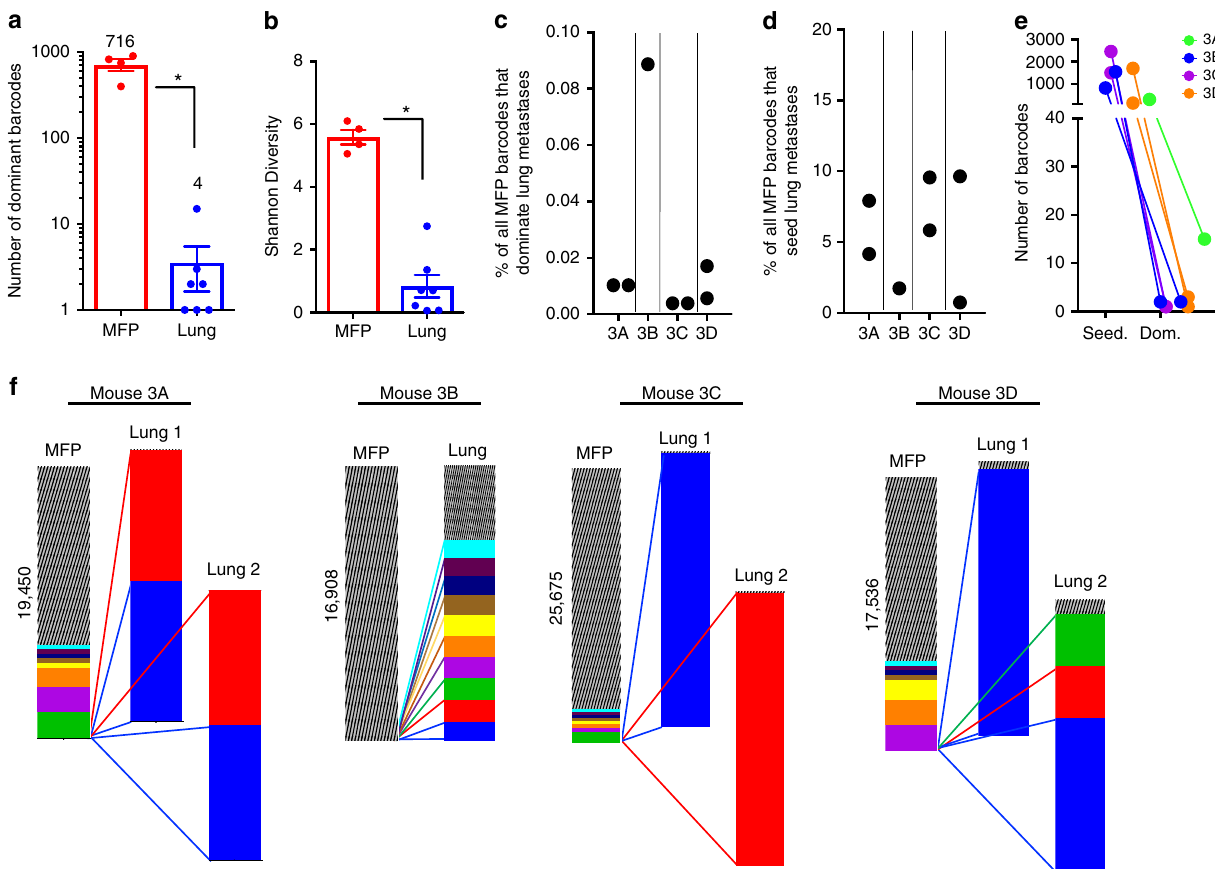
Fig. 6 An additional PDX model reveals clonal selection during metastasis. a In BC3_A2, unique dominant barcodes in each sample were quanti fi ed and plotted. The mean quantity of unique barcodes present in each site is depicted above each bar. (two-tailed T -test, * p = 9.40e − 6; error bars are SEM; n = 4 MFP tumors, n = 7 lung metastases). b In BC3_A2, Shannon Diversity Indices were calculated (in nats: natural digits) taking into account all barcodes for each sample as a measure of ITH. (two-tailed T -test, * p = 7.55e − 6; error bars are SEM; n = 4 MFP tumors, n = 7 lung metastases). c In BC3_A2, the percent of dominant barcodes (top 95%) in each metastatic lesion relative to the total number of unique barcodes detected in its matched MFP tumor is shown (labeled 3A – 3D). d In BC3_A2, the percent of seeding clones detected in each metastatic lesion relative to the total number of unique barcodes detected in its matched MFP tumor is shown. e In BC3_A2, the number of dominant barcodes in metastases of each organ was compared with the total number of seeding clones detected in each metastasis. f In BC3_A2, the frequencies of the 10 most abundant barcodes detected across all samples within each mouse are plotted in different colors. Gray striped bars represent all other barcodes in each sample comprising the remainder of the population, and the numbers of these barcodes detected in each MFP tumor is written. Barcodes marked by the same colors in different mice are not identical to one another. Colored lines indicate expansion of primary tumor clones in metastatic lesions, although cross-metastasis seeding may have also